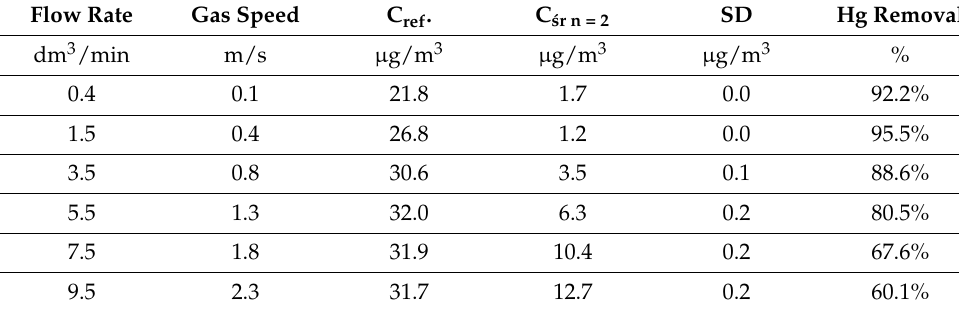
Table 2. The effect of gas velocity on mercury removal efficiency